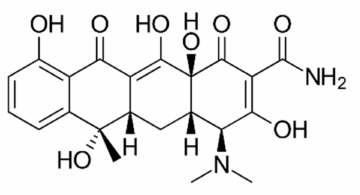
Figure 1. Molecular structure of